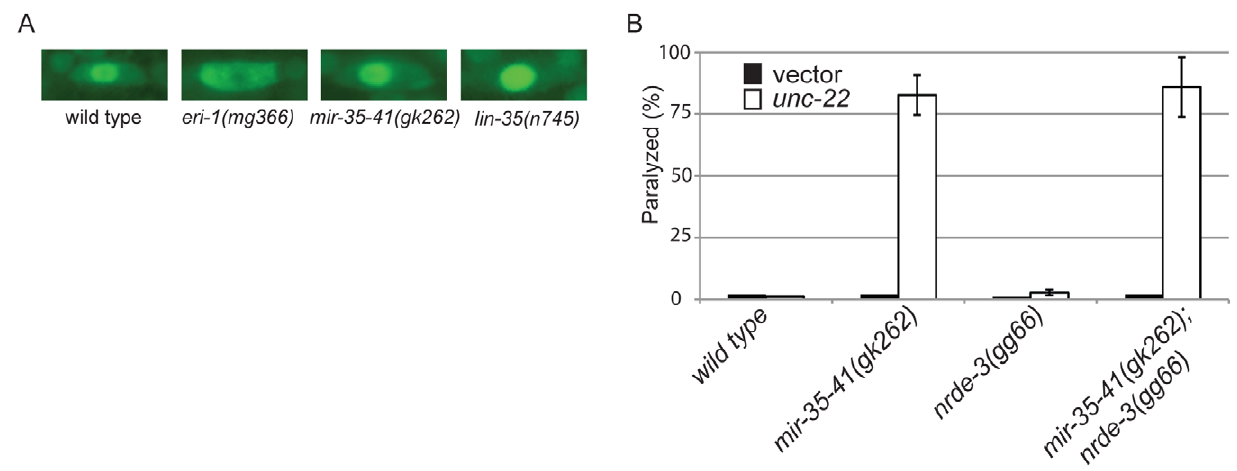
Figure 2. The RNAi hypersensitivity of mir-35-41 mutants is independent of nrde-3 activity. (A) Fluorescent microscopy showing subcellular localization of GFP::NRDE-3 in seam cells of the indicated genotypes. Pictures are representative of 50 worms analyzed for each strain. (B) Histogram representing the percentages of paralyzed worms for the indicated strains fed unc-22 dsRNA for 28 hours from the L4 to adult stage. The means and standard deviations from three independent experiments are graphed.